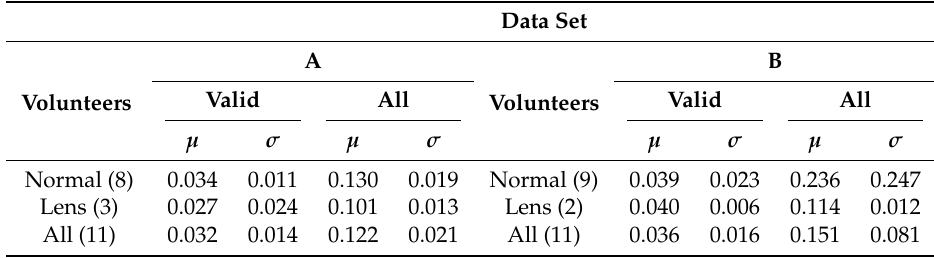
Table 2. Statistical results of the precision using the data samples of the fixation tests. The number of volunteers is indicated in parenthesis; floating-point values represent angular distances in degrees. Data